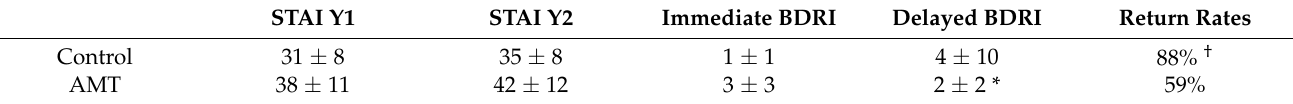
Scores are presented as mean ± SD. STAI = State-Trait Anxiety Inventory; BDRI = Blood Donation Reactions Inventory; Return rates = will- ingness to donate again. * denotes significant difference between immediate and delayed BDRI in the AMT group ( p < 0.05) and † denotes significant difference between groups ( p <